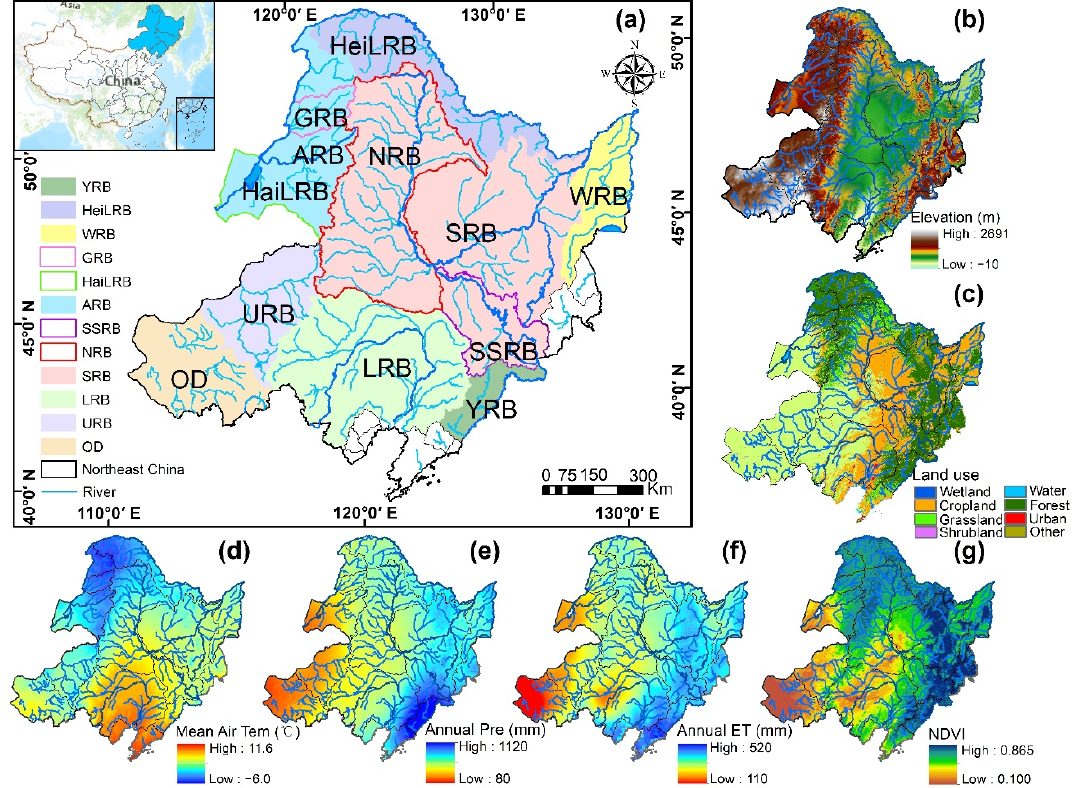
Figure 1. Spatial distribution of hydrology and driving factors in the study area. ( a ) Geographical location and watershed distribution of the study area. The main basins are: Yalu River Basin (YRB); Heilong River Basin (HeiLRB); Wusuli River Basin (WRB); Gen River Basin (GRB); Hailar River Basin (HaiLRB); Argun River Basin (ARB); Second Songhua River Basin (SSRB); Nen River Basin (NRB); Songhua River Basin (SRB); Liao River Basin (LRB); Ulagai River Basin (URB); Otindag Desert (OD). ( b ) Altitude, ( c ) land-use type, ( d ) mean air temperature, ( e ) annual precipitation, ( f ) annual evapotranspiration, and ( g )